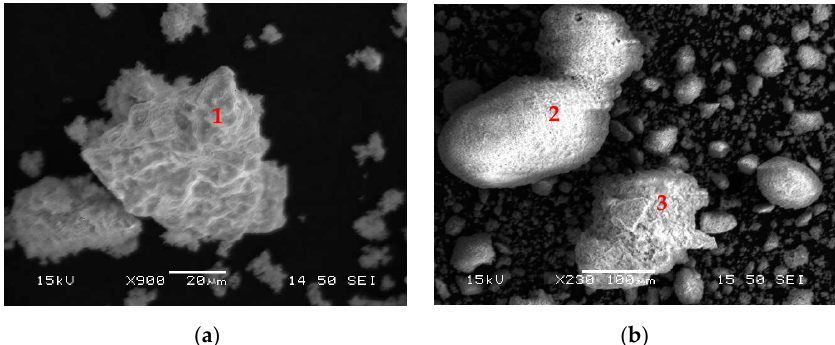
Figure 20. SEM mineral identifications in BaO, Na 2 CO 3 and bauxite residue ( a ) sinter products; (1) Barium titanate, and ( b ) Leached residue; (2) Barium titanium iron calcium aluminum silicon oxide (3) Barium iron calcium aluminum silicon oxide (more details in Supplementary Materials). 3.7. Experimental Results of Leaching Tests from 50% Excess Soda Sinters with CaO, MgO and BaO